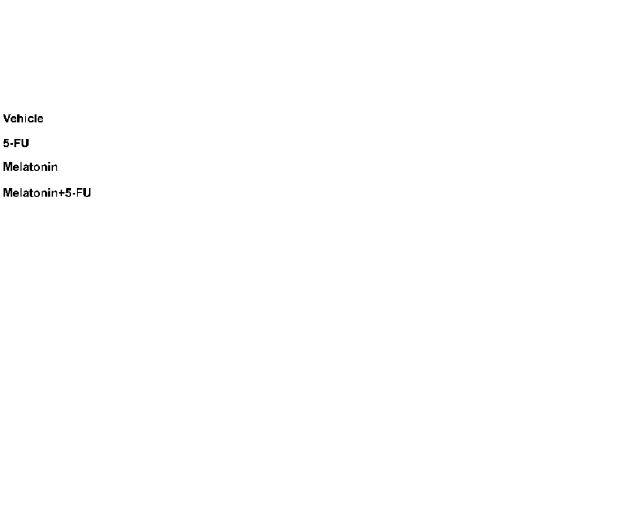
9 of 14 Figure 5. DCX ( A ), Nrf2 ( B ) and BDNF ( C ) protein expression in the hippocampus. ## p < 0.01 and ### p < 0.001 compared with the vehicle group. * p < 0.05 and *** p < 0.001 compared with the 5-FU group. Doublecortin: DCX; nuclear factor erythroid 2-related factor 2: Nrf2; brain derived neu- rotrophic factor: BDNF. There were significant differences in the Nrf2 and BDNF expression levels in the PFC between the vehicle and the 5-FU groups as shown in Figure 6A,B. There were significant increases in the expression of Nrf2 (mean ± SEM; 5-FU: 75.32 ± 5.86, melatonin: 108.20 ± 4.87, melatonin+5-FU: 97.58 ± 5.95, p < 0.05, p < 0.01, Figure 6A) and BDNF (mean ± SEM;